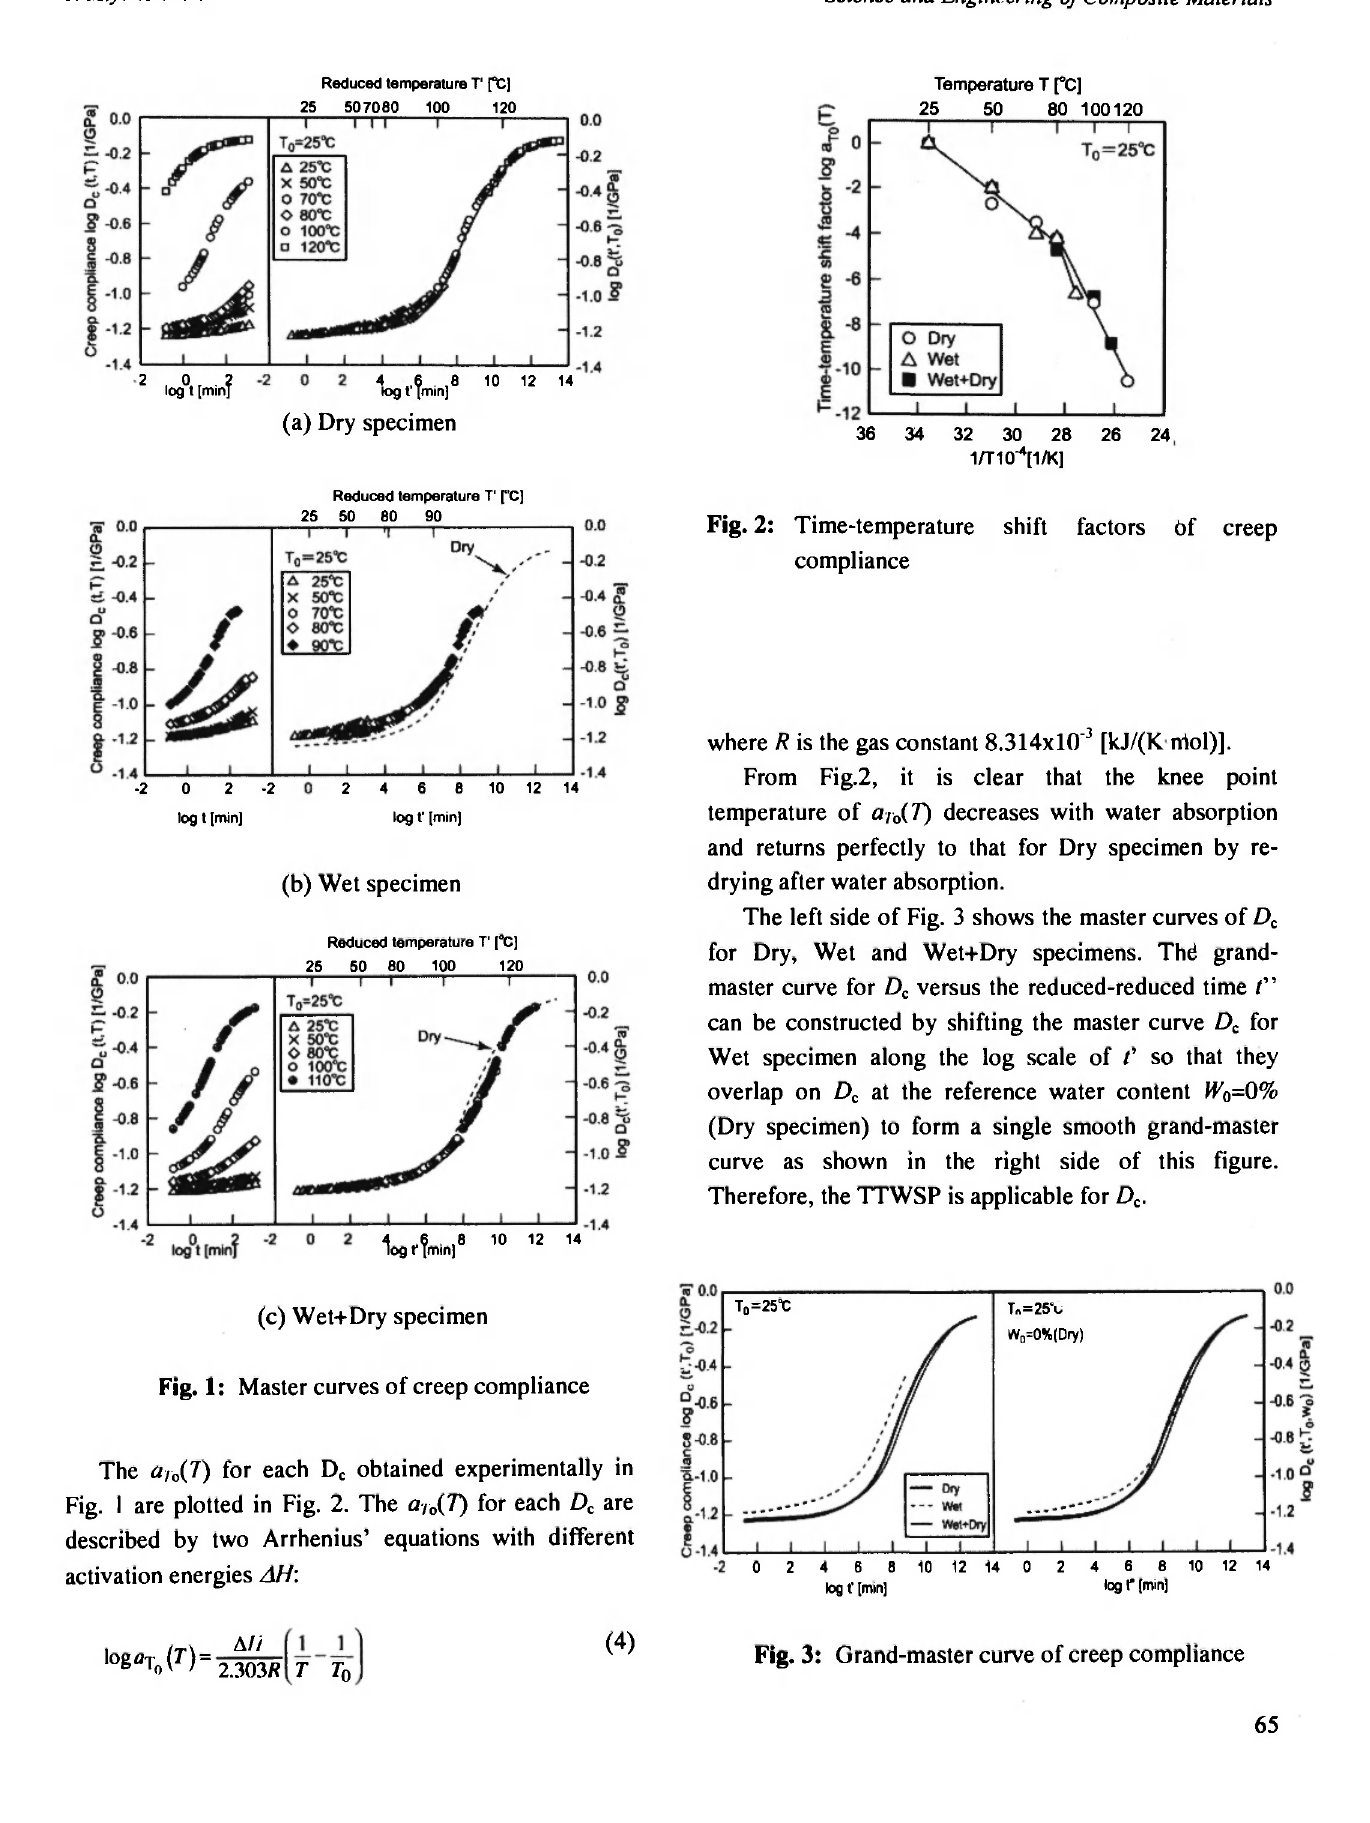
Fig. 1: Master curves of creep compliance